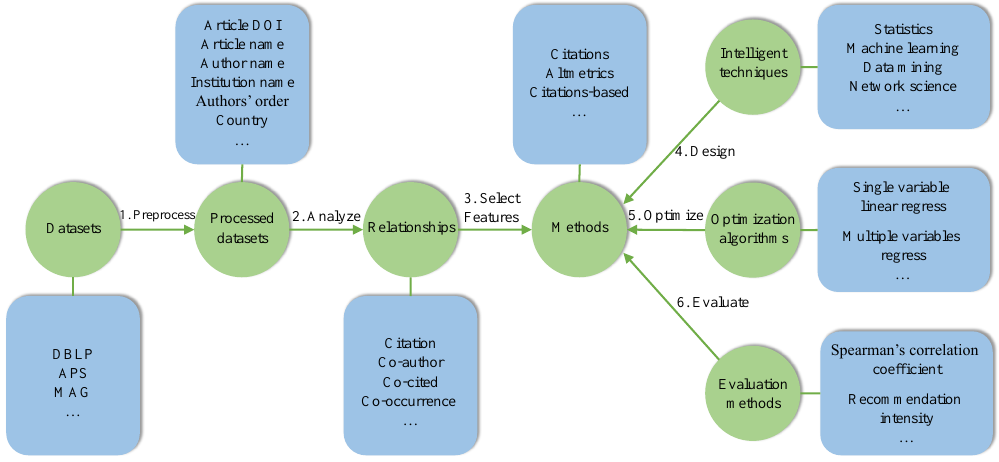
Figure 4. Frameworks of evaluating article